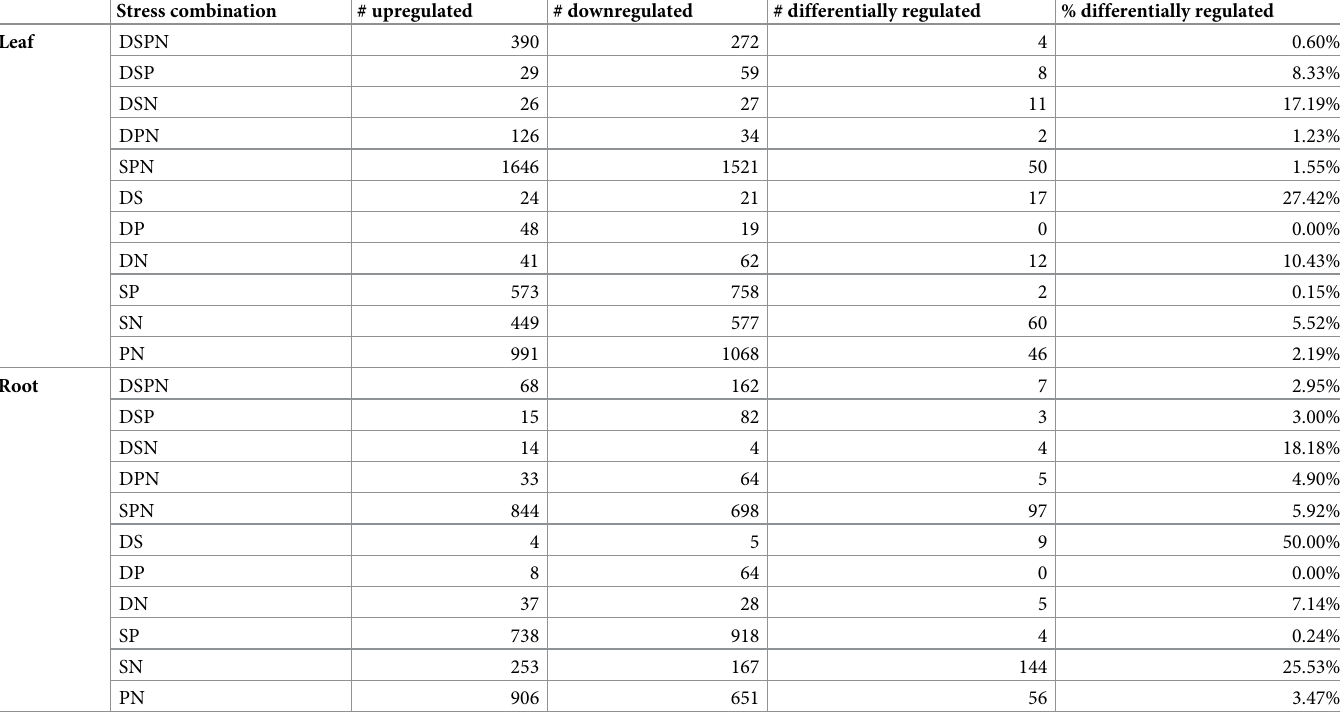
Table 3. Directionality of DEG expression among stress intersections. Stress